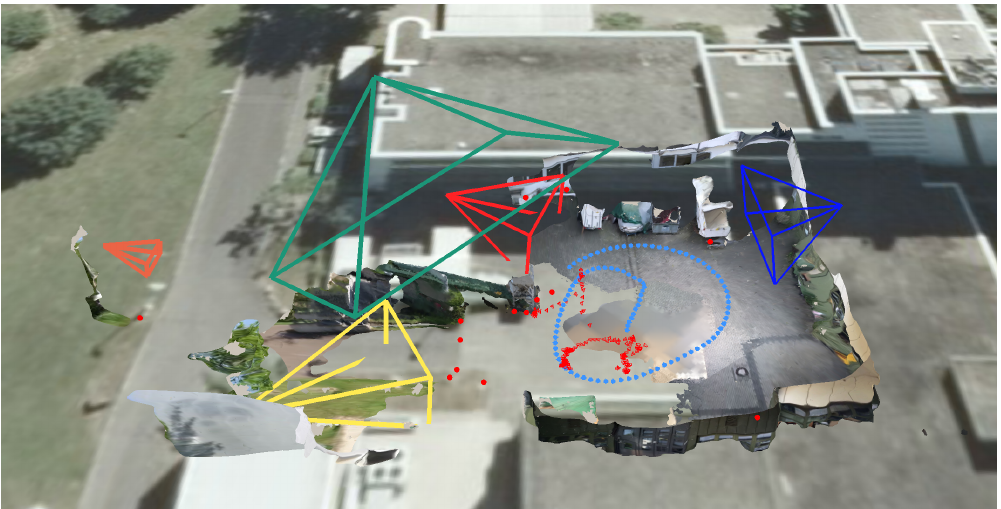
Figure 2. 3D reconstruction after being manually geo-registered into satellite imagery based map